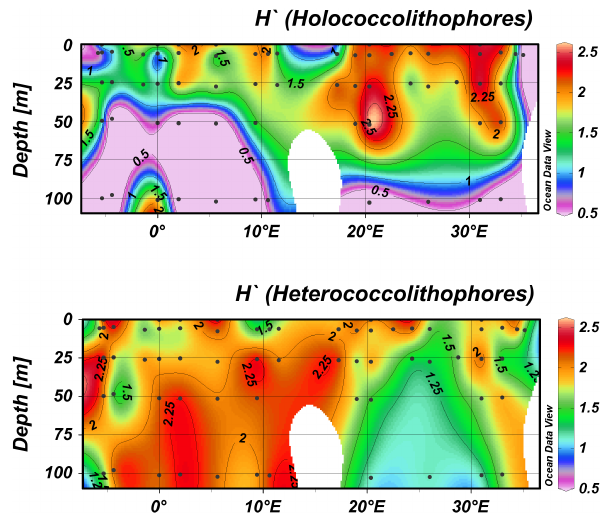
Figure 9. Shannon–Wiener diversity index for holococcol- Figure 9. Shannon-Weiner diversity index for holococcolithophores and heterococcolithophores. A ithophores and heterococcolithophores. A higher index, or higher higher index, or higher uncertainty in correctly guessing the “next species” that would be sampled, is uncertainty in correctly guessing the “next species” that would be representative of a more diverse community. sampled, is representative of a more diverse